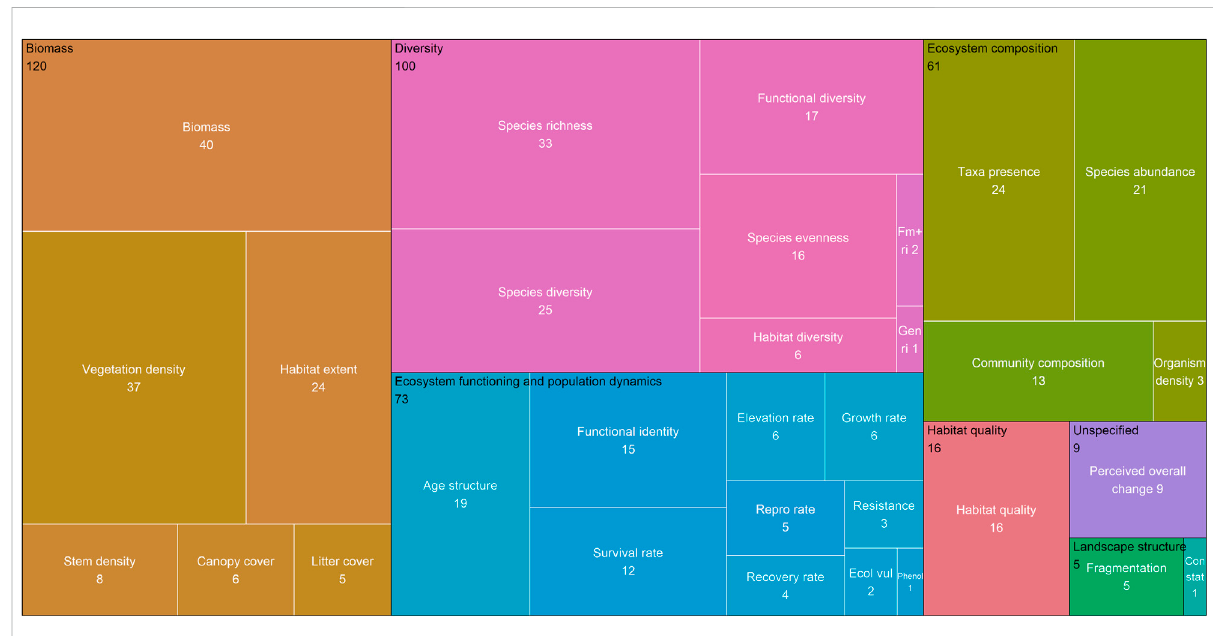
FIGURE 2 Frequency of use of ecosystem health metrics, grouped by broad metric categories. Box areas are proportional to frequency of use of ecosystem health metrics; metric names are in white; broad metric category names are in black; colours correspond to broad metric categories. 385 outcomes are represented here, across 109 interventions. Gen ri = generic richness; Fm + ri = family and above richness; Repro rate = reproductive rate; Ecol vul = ecological vulnerability; Phenol = phenology; Con stat = conservation status. Two metrics that were de fi ned a priori were not used at all by the studies: genetic diversity and phylogenetic diversity. For the number of interventions in each group, see Supplementary Table